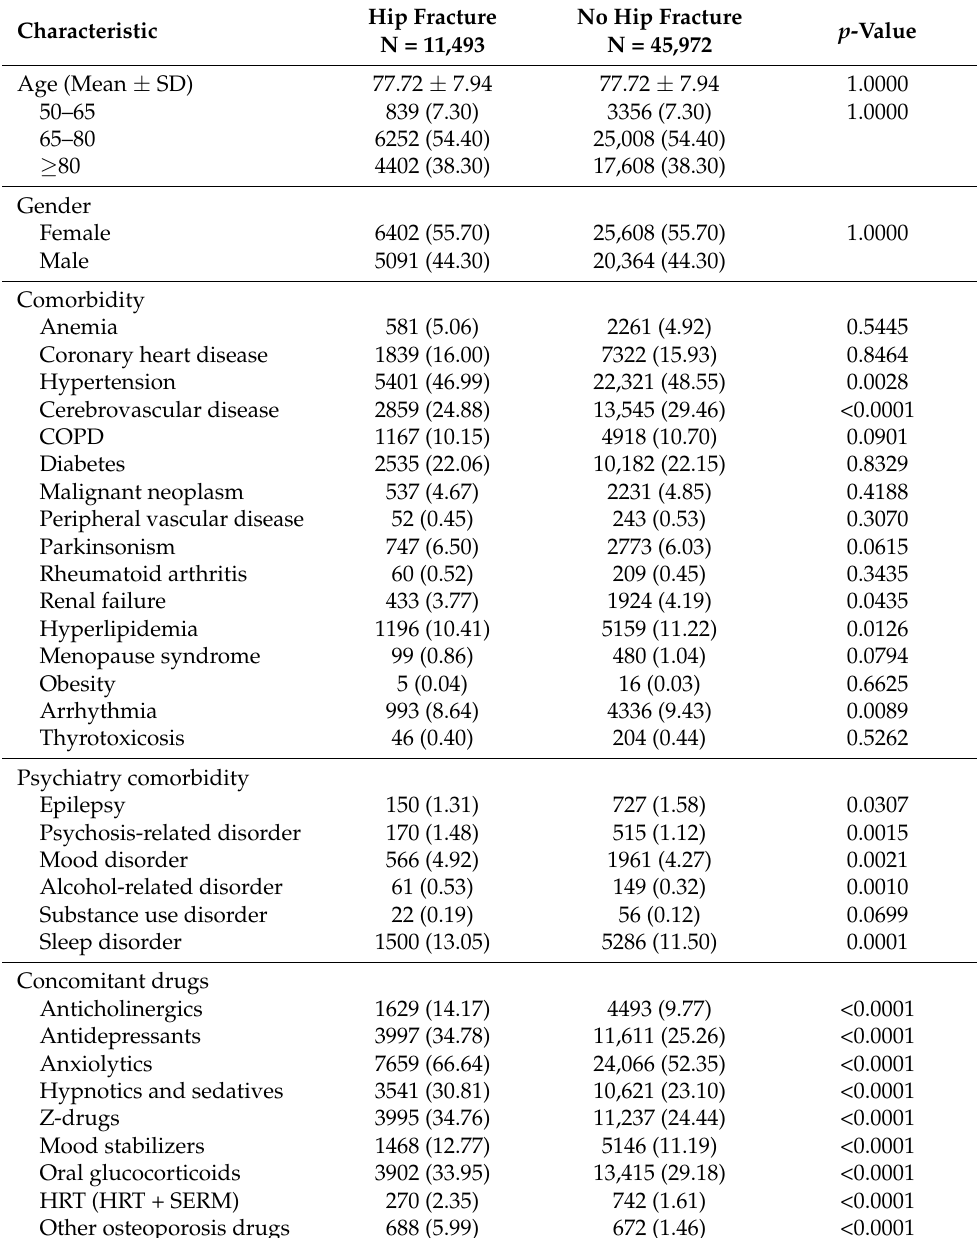
Table 1. Demographics and characteristics of cases of hip fracture and their